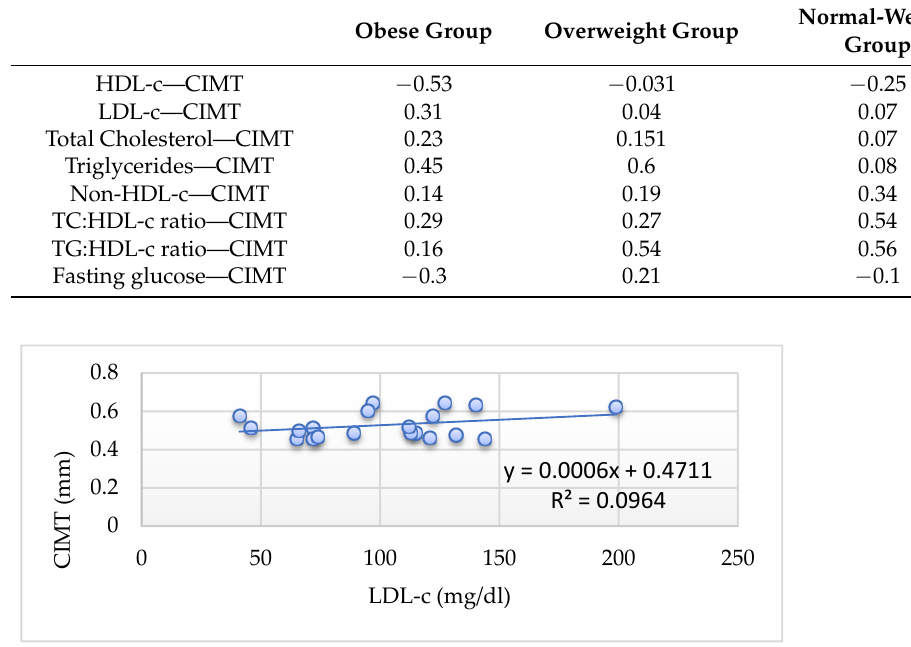
Table 8. Correlations between CIMT and blood parameters (Spearman’s correlation for the obese and normal-weight group and Pearson correlation for the overweight group).